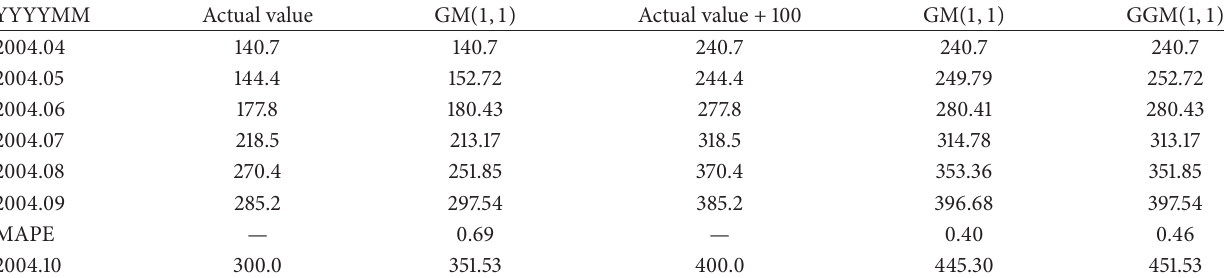
Table 4: The result of landslide forecasting in BaZiMen